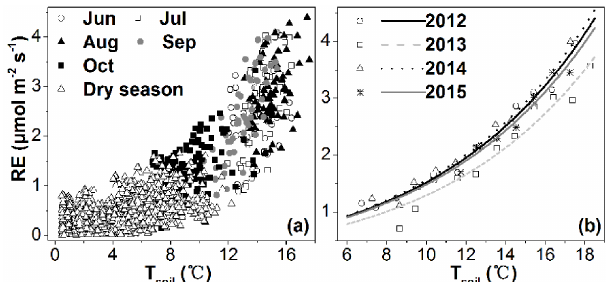
Figure 3. (a) Relationship between RE and T soil in 2012; (b) re- lationship between RE and Tsoil for the wet season from 2012 to 2015; RE and T soil were averaged with T soil bins of 1 ◦ C.